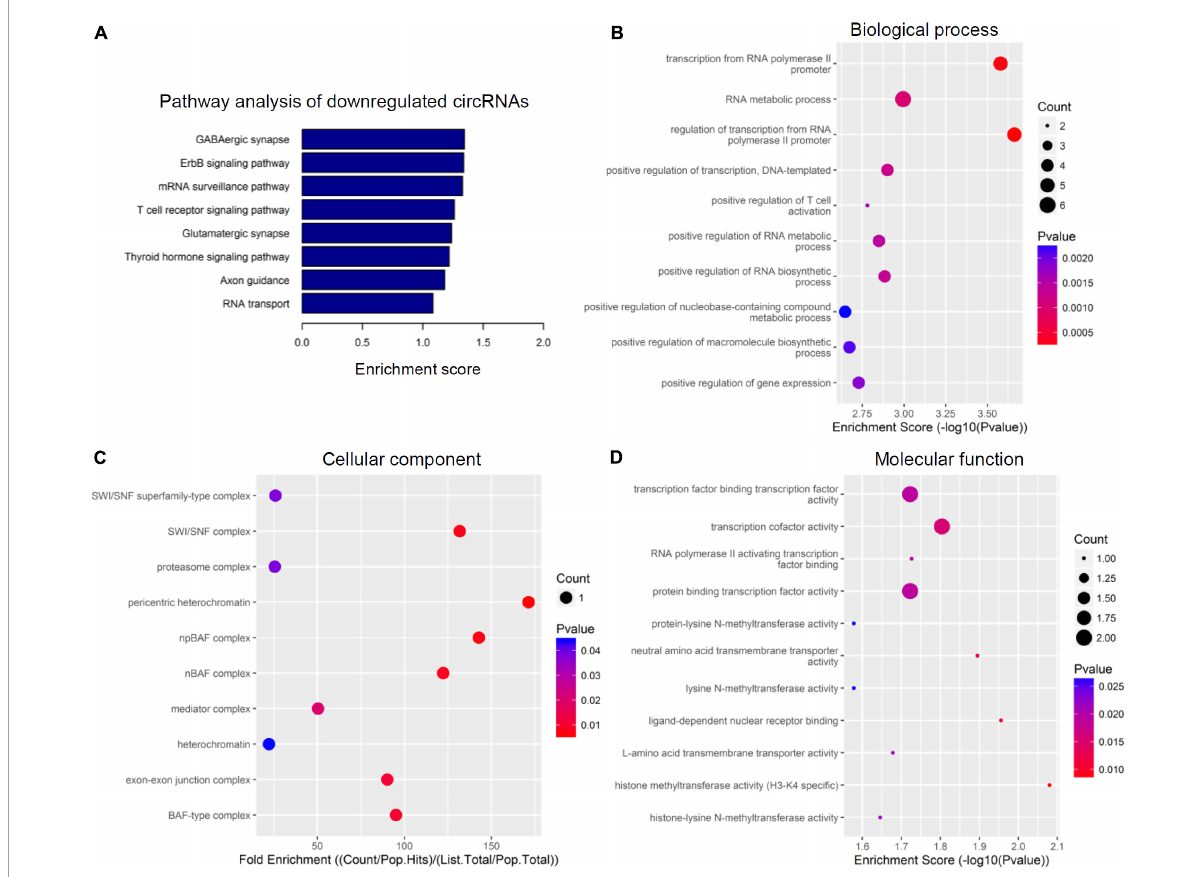
FIGURE4 Kyoto encyclopedia of genes and genomes (KEGG) pathway analysis and gene ontology (GO) function analysis of downregulated circular RNAs (circRNAs) from circulating exosomes. (A) KEGG pathway analysis of downregulated circRNAs from circulating exosomes. (B–D) GO function analysis of downregulated circRNAs from circulating exosomes. (B) Biological process analysis of downregulated circRNAs from circulating exosomes. (C) Cellular component analysis of downregulated circRNAs from circulating exosomes. (D) Molecular function analysis of downregulated circRNAs from circulating